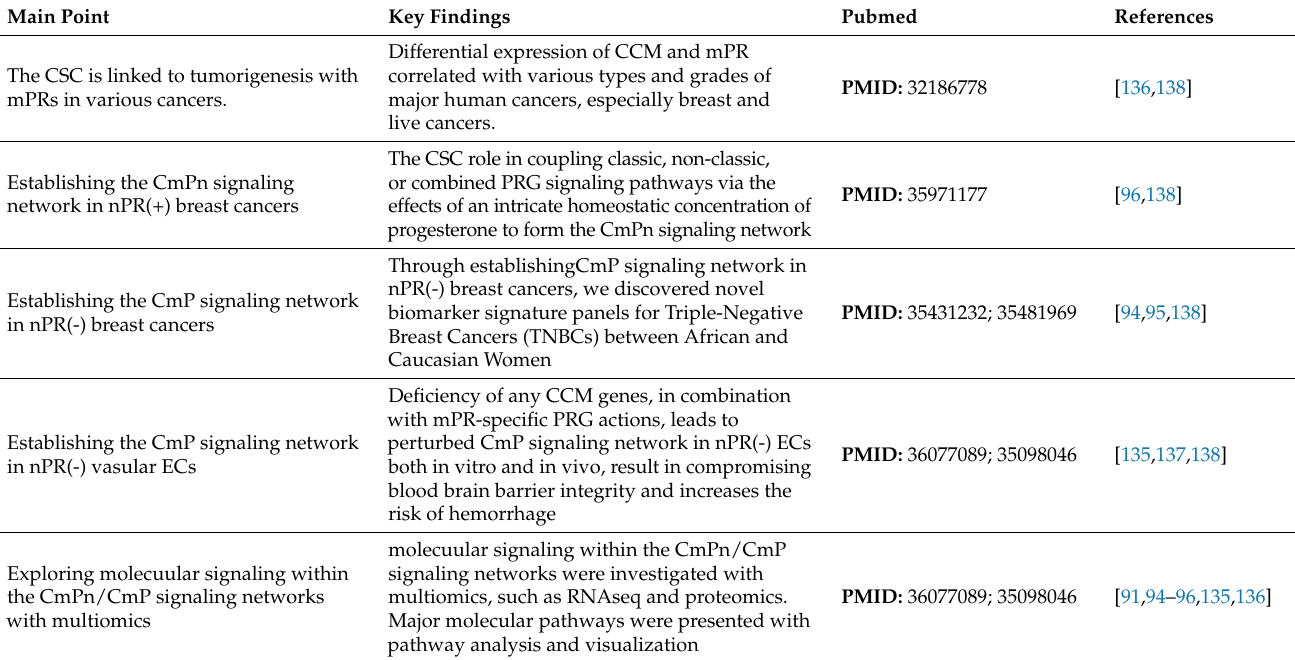
Figure 1. Signaling network bridge “crosstalk” among key players within CmPn signaling network. The diagram displays the relationship among PRG, nPR, mPR, CSC, and zinc (Zn). We show that the zinc interacts with all major players within the CmPn signaling network and involved in CmPn-modulating signaling during breast cancer tumorigenesis. Table 1. Detailed information regarding the CmPn signaling network. A list of recent key publications describing CmPn and CmP signaling networks among nPR(+) and nPR(−) cancers and vascular ECs.